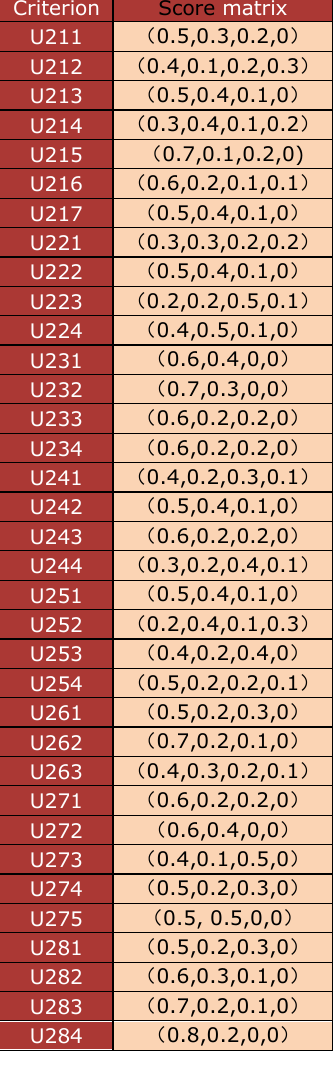
Table 4. Criteria scores matrix